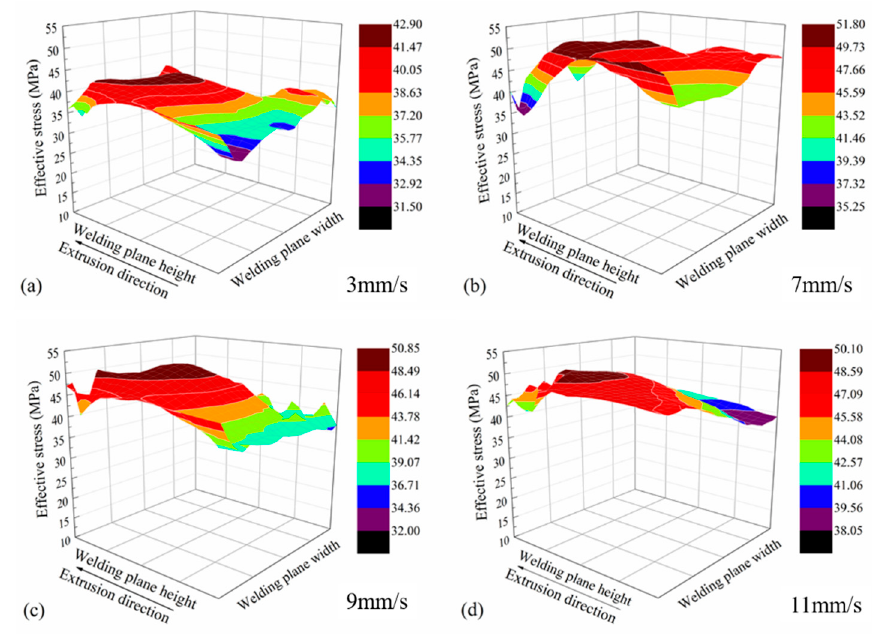
Figure 5. Effective stress distributions on the welding planes. ( a – d ) different ram speed.